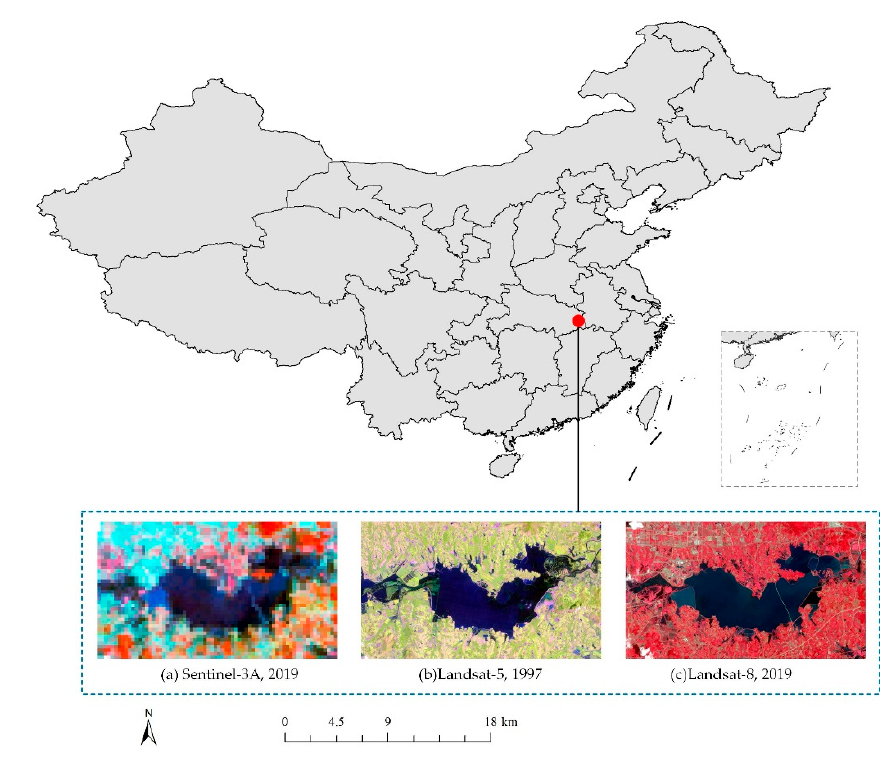
Figure 6. Original image of Daye Lake.